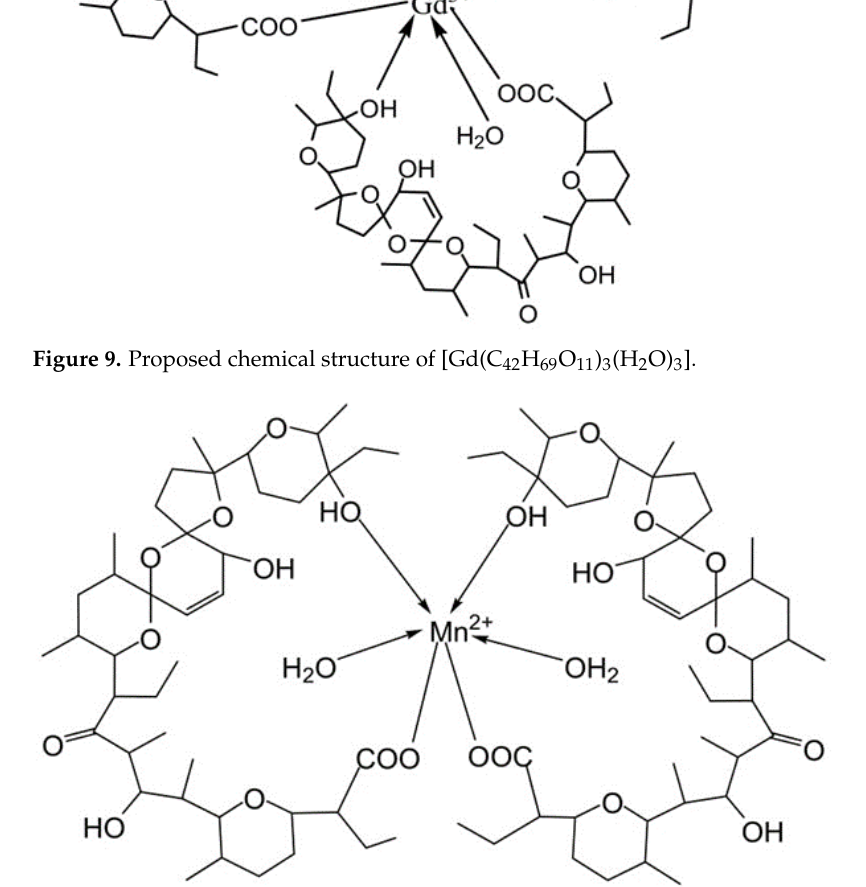
Figure 10. Proposed chemical structure of [Mn(C 42 H 69 O 11 ) 2 (H 2 O) 2 ].